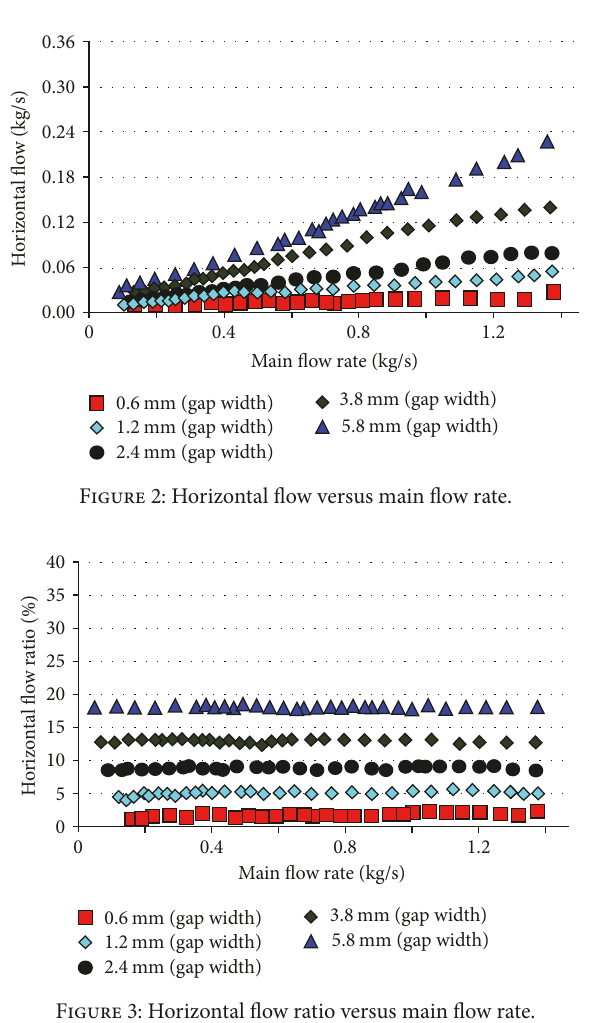
changes in the primary flow rates. Some slight variations were noticed but are theoretically negligible since they cannot influence the decision.